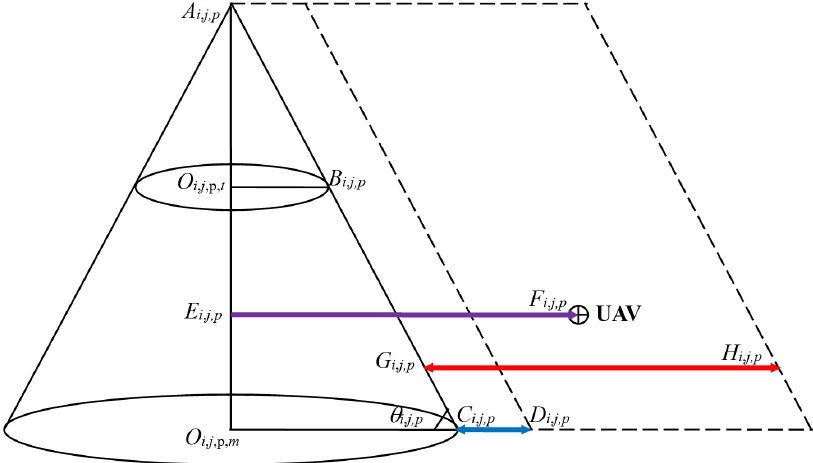
Figure 5. Sketch map of the upland threat source model.